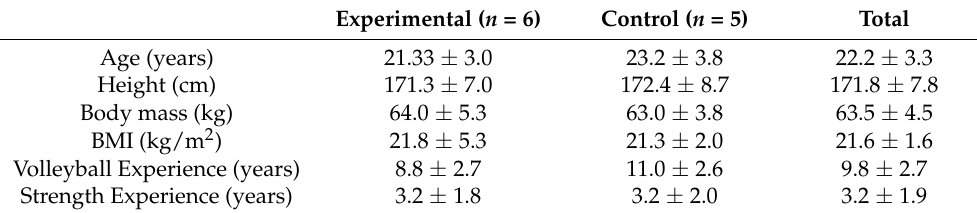
Table 1. Characteristics of the subjects aggregated by group (mean ±